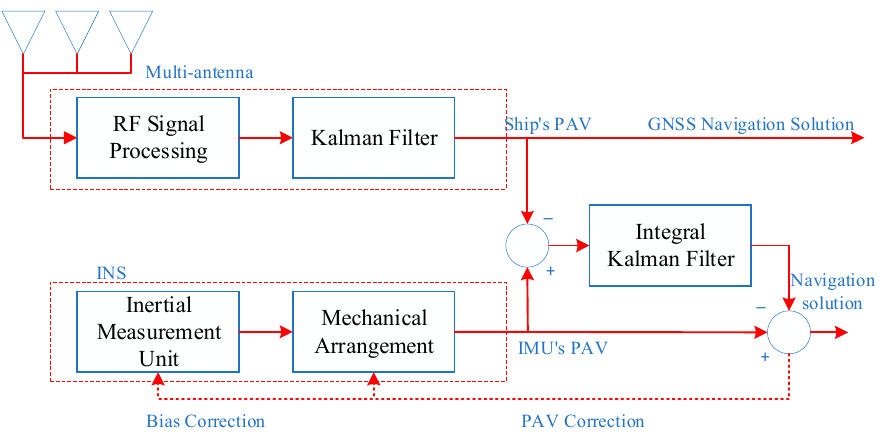
Figure 4. Multi-antenna GNSS/INS loose combination algorithm model.